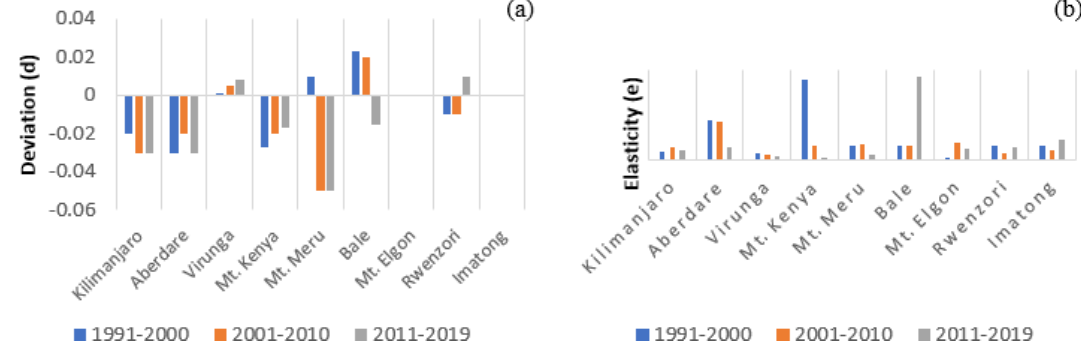
Figure 11. Illustration of the water towers in the Budyko space. (a) The deviation from the Budyko curve and (b) elasticity are